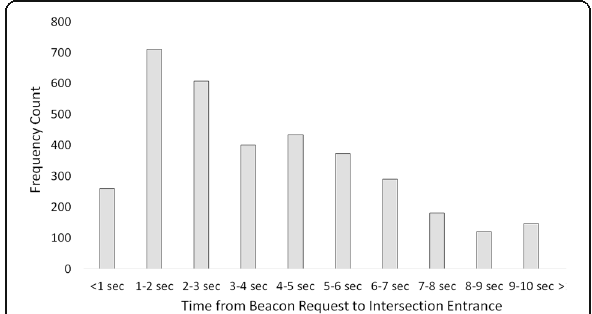
Fig. 2 Histogram depicting the frequency of beacon requests resulting in an intersection entrance within the next 1 to 10